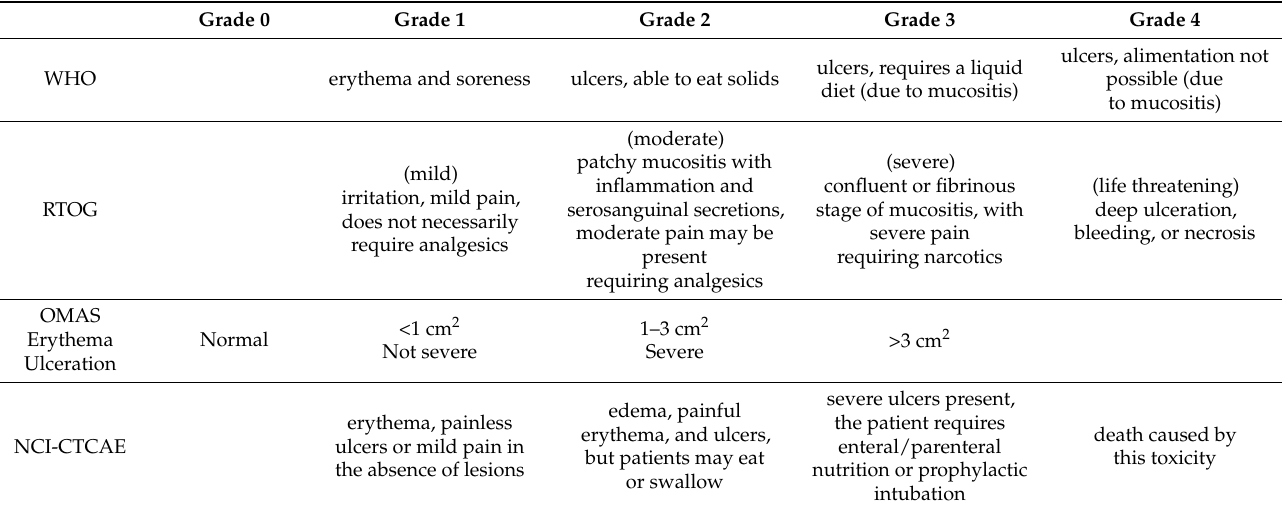
Table 1. Examples of tools used to assess